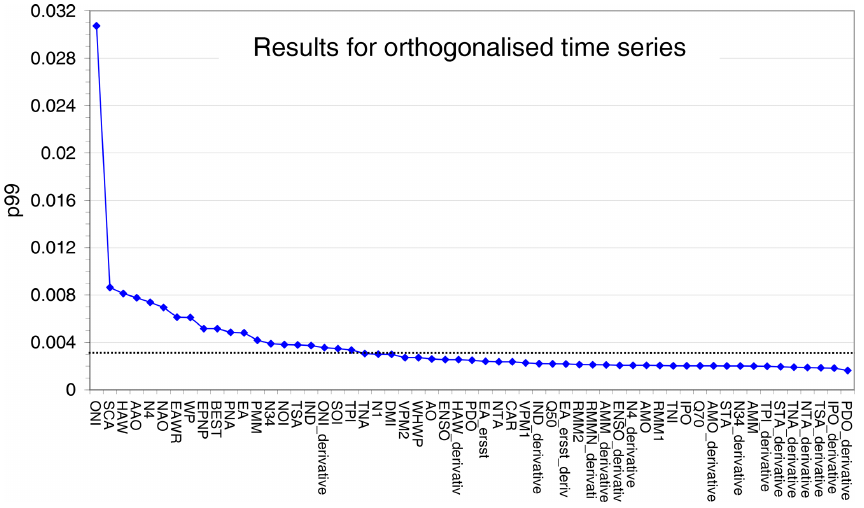
Figure 10. The 99th percentiles (p99) of the delta rms of the orthogonalised indices. The black lines represent the significance threshold. The indices are sorted from highest to lowest p99